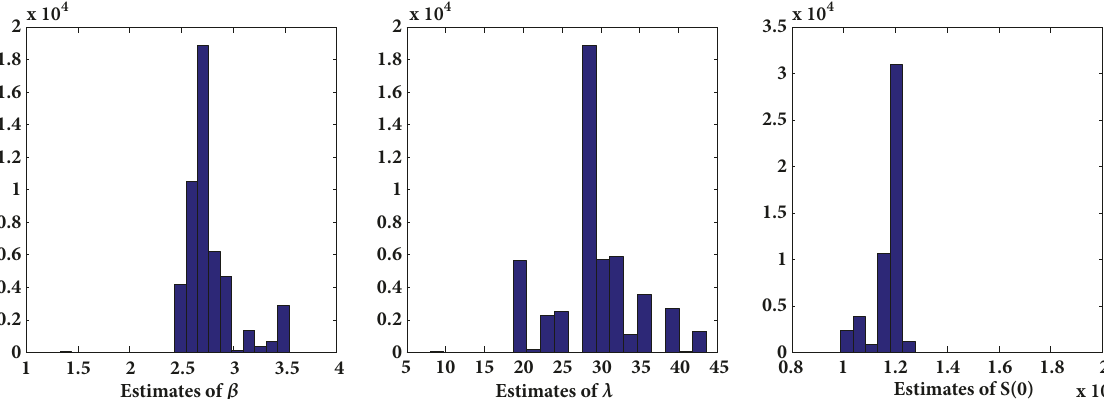
Figure 3: Histograms of 50, 000 Bayesian estimators of 𝛽,𝜆 , and 𝑆(0) . The data are simulated from the model with parameters 𝛽 = 2.6,𝜆 = 28, 𝑆(0) = 12, 000 , 𝑑 = 5, 𝑃 = 1/5 (1 ≤ 𝜏 ≤ 5) , 𝑁 = 20, 000 , and 𝑖(𝑡) = 10 for 1 ≤ 𝑡 ≤ 5 𝜏